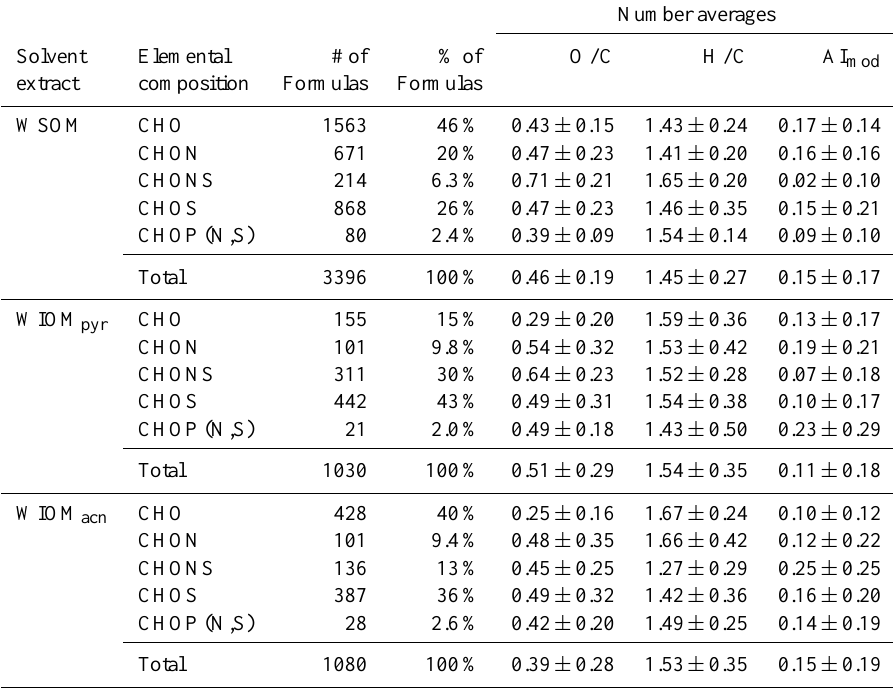
Table 1. Molecular formula distributions for each solvent extract based on elemental composition with number average characteristics. The values for PSOM and ASOM do not include formulas common with WSOM and thus represent characteristics for